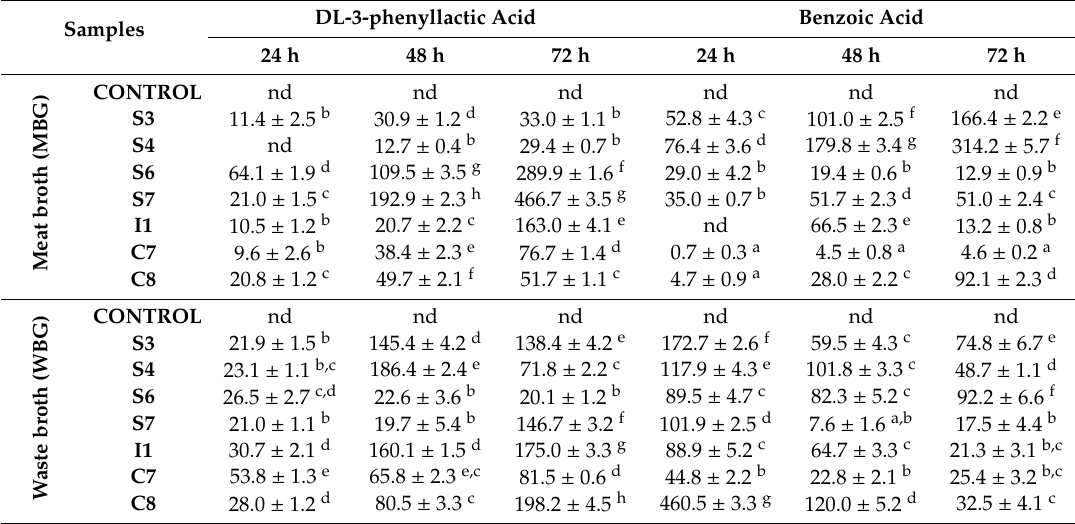
Table 3. Phenolic acids in fermented and control